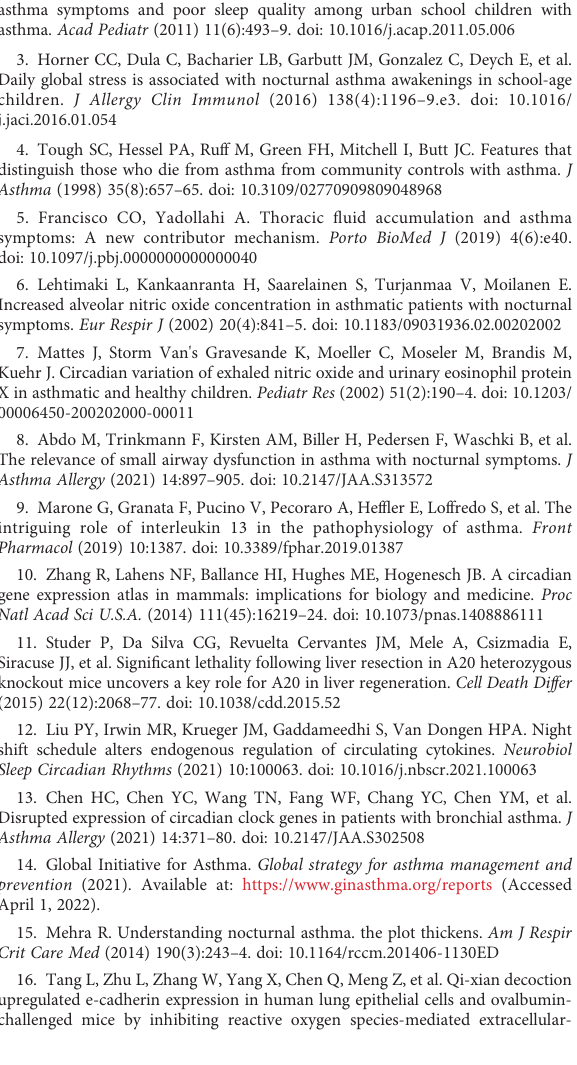
SUPPLEMENTARY TABLE 2 Sequences of primers used. SUPPLEMENTARY TABLE 3 Pearson ’ s correlation coef fi cient for the concentrations of circadian clock genes and in fl ammatory cytokines in the mice lung tissues. Pearson ’ s correlation coef fi cient was used to measure the strength of the relationship between the two variables. * p < 0.05, ** p < 0.01.